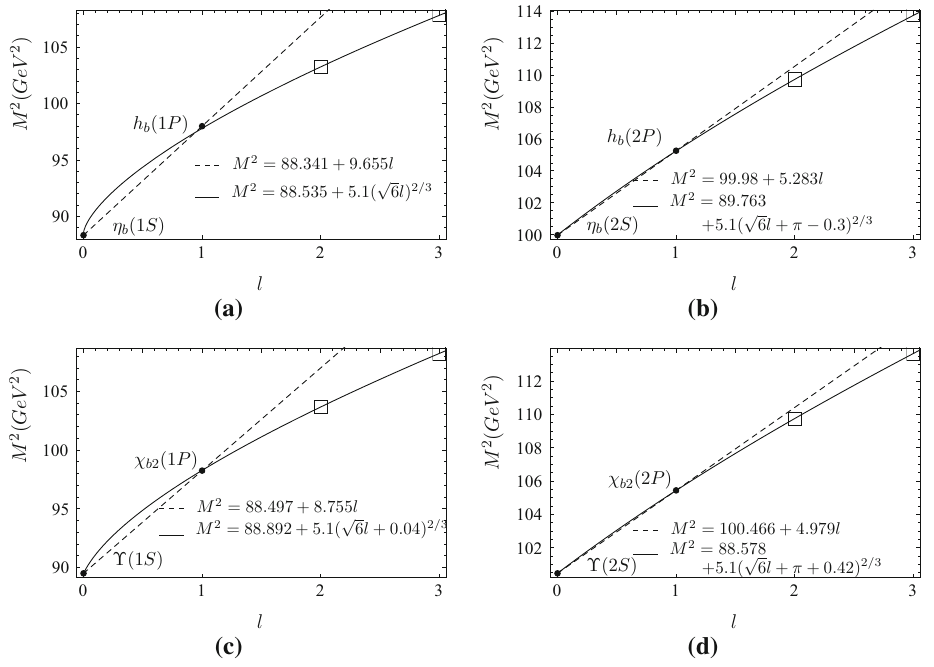
Fig. 4 Same as Fig. 3 except for the orbital Regge trajectories